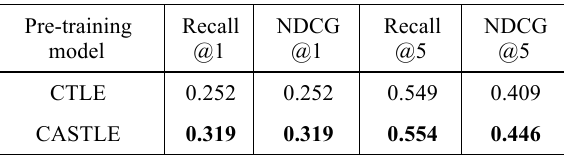
Table 2. Pre-training performance comparison.